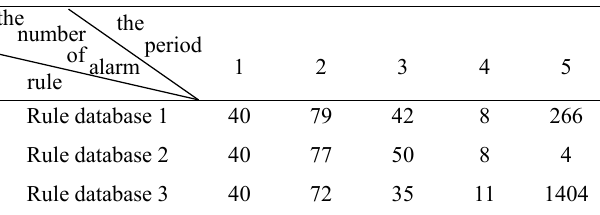
Table 1: the number of alarm based on different rule in